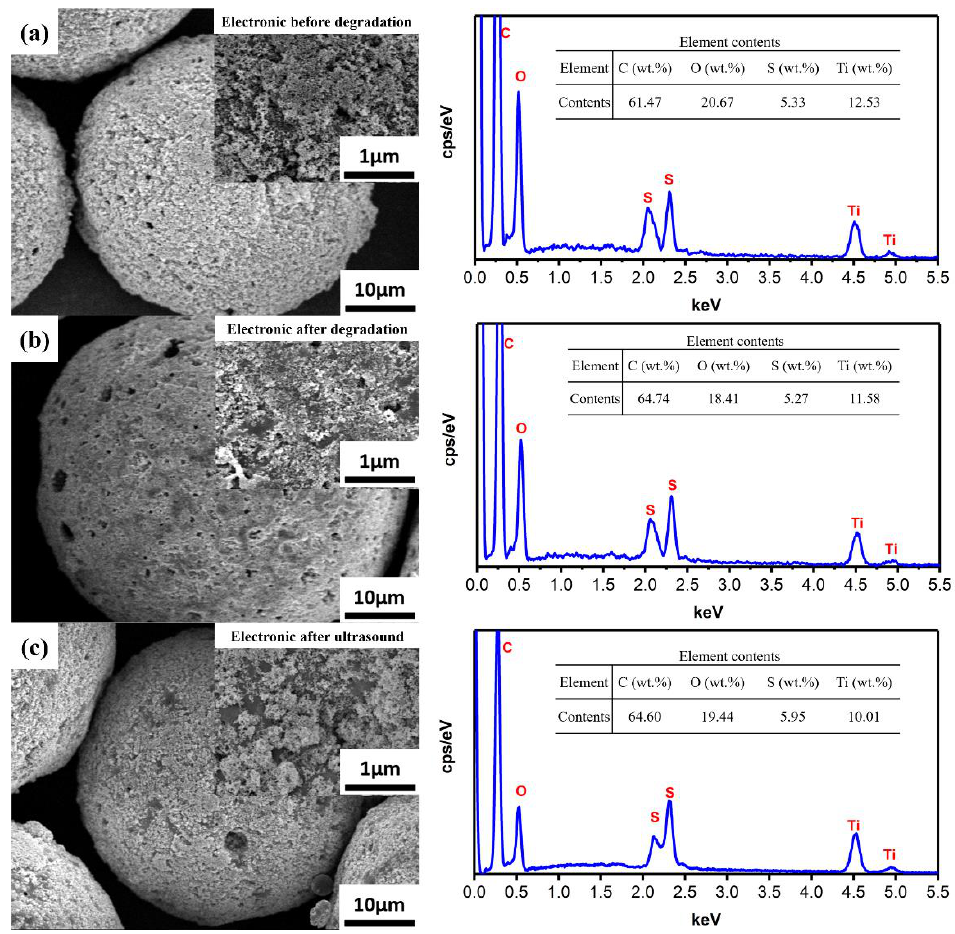
Figure 7. SEM images and energy dispersive spectrometer (EDS) spectrum of ( a ) TiNPs/PSF-0.40 composite microspheres before degradation, ( b ) after degradation 20 times, and ( c ) after ultrasound treatment.